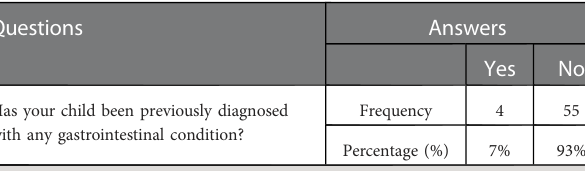
TABLE 3 Family history and previous diagnosis with gastrointestinal